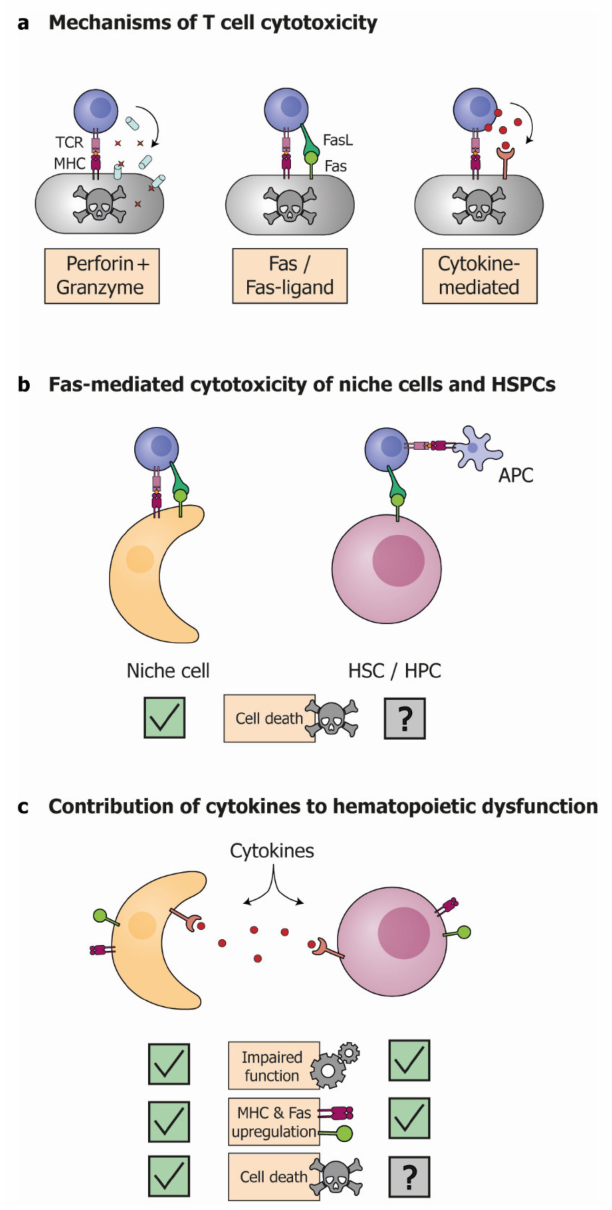
Figure 2. Mechanisms of GvHD-related hematopoietic dysfunction ( a ) T cells can induce target cell destruction via perforin/granzyme, Fas/FasL and cytokine-mediated cytotoxicity; ( b ) Fas-mediated destruction of niche cells contributes to GvHD-related hematopoietic dysfunction. Fas-mediated cytotoxicity does not require MHC expression on target cells, but whether donor HSPCs are destroyed by donor T cells remains subject of debate; ( c ) during GvHD, high cytokine levels may induce apoptosis in niche cells, and potentially in HSPCs. Cytokines increase the expression of MHC and Fas on target cells. Furthermore, cytokines impair the function of niche cells and HSPCs. TCR: T cell receptor; MHC: major histocompatibility complex; FasL: Fas-ligand; APC: antigen presenting cell; HSC: hematopoietic stem cell; HPC: hematopoietic progenitor